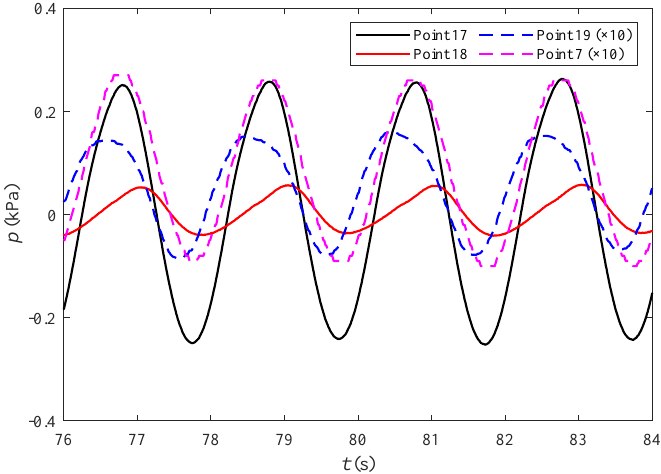
Figure 11. Distribution of pore-water pressures vs time behind the pile for Test 43 ( x = − 0.15 m, T = 2.0 s, H = 10